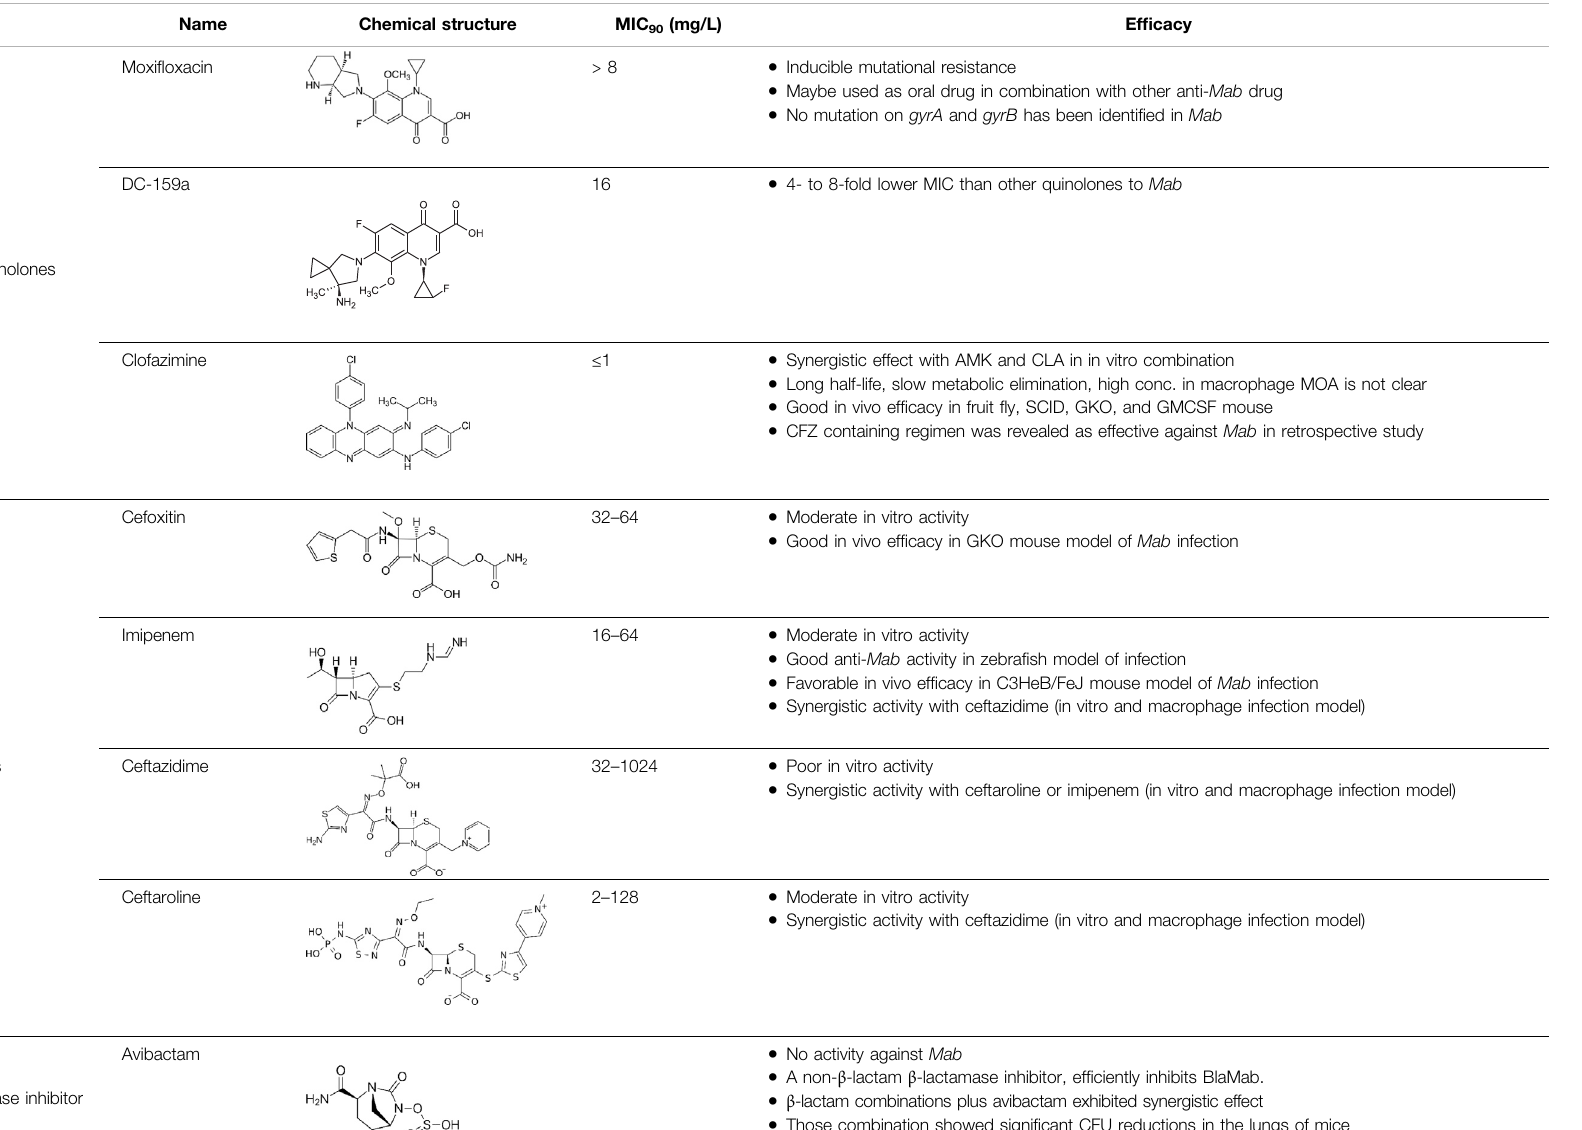
TABLE 2 | ( Continued ) The current state of Mab antibiotics, with compounds currently going through development. * Indicates MIC 50